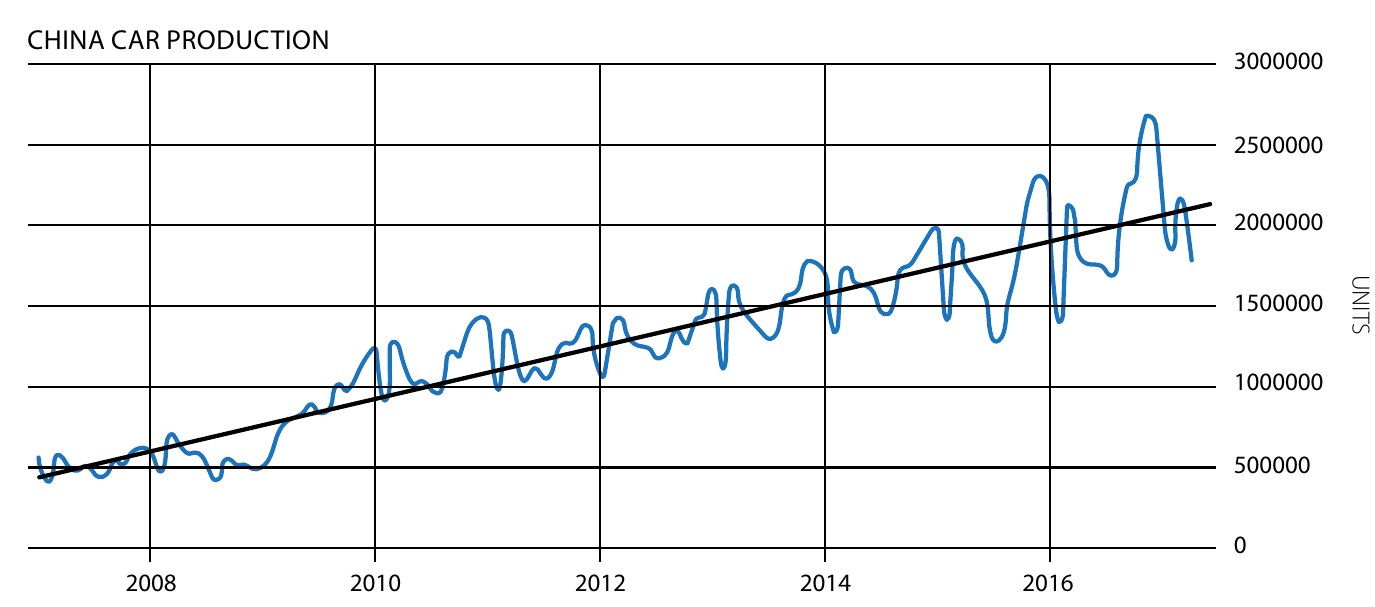
Figure 1. Growth Trend of China’s Auto